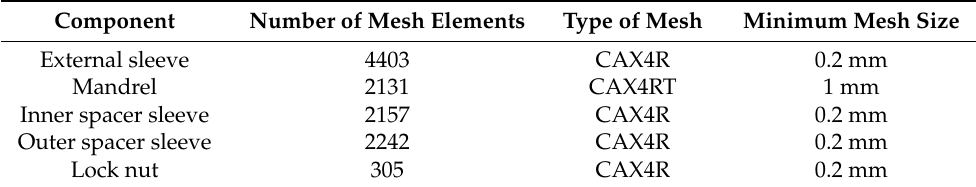
Table 6. Mesh parameters of important components in